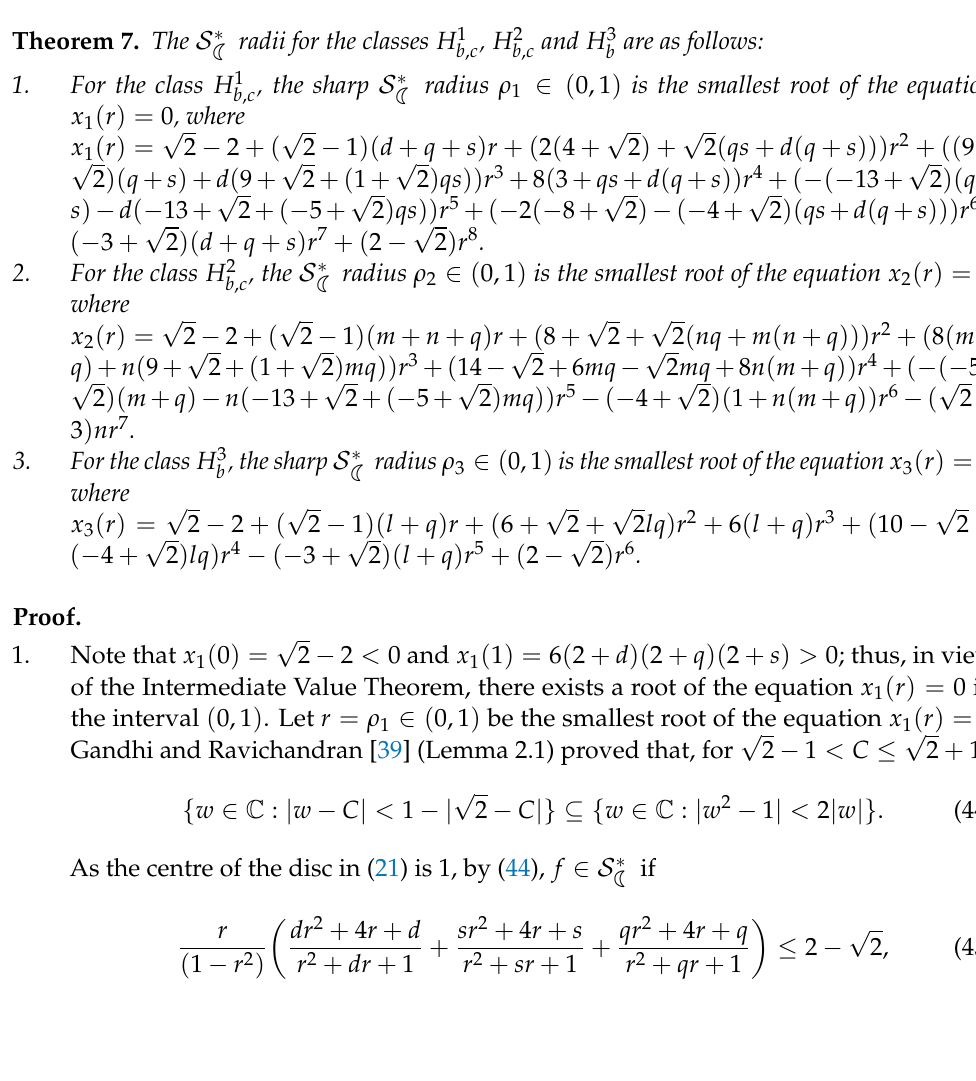
radii for H 1 sin